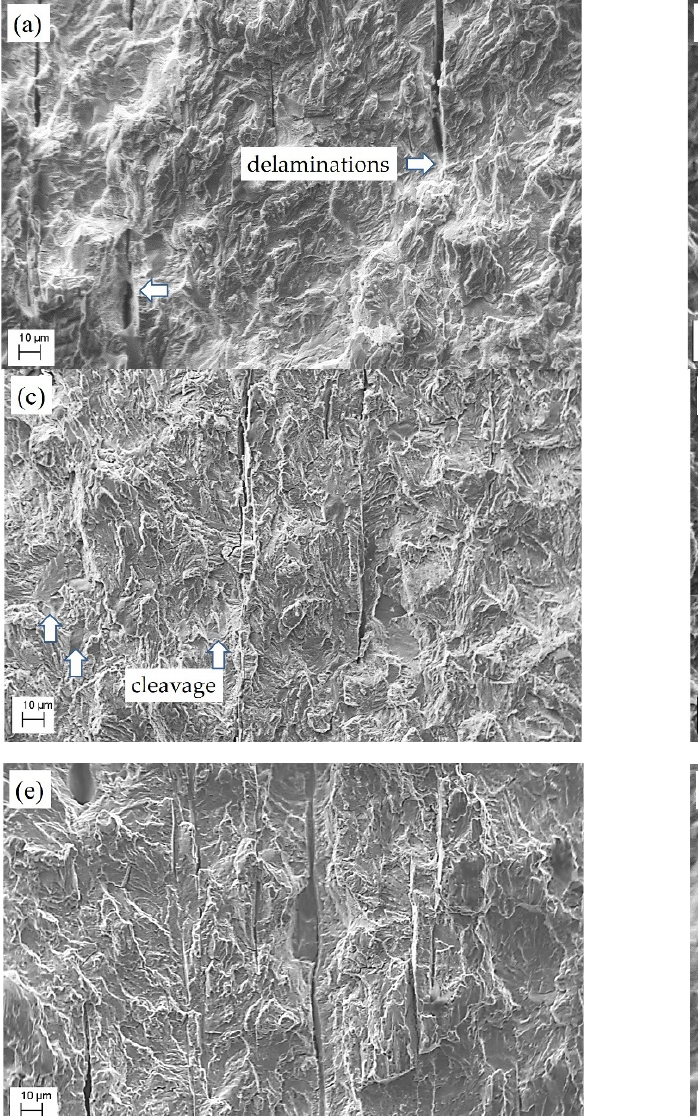
Figure 12. SEM fractography of specimens of 17H1S steel ( a , b ) in the AR state and ( c – f ) after LTO cut from the upper ( c , d ) and lower ( e , f ) parts of the corresponding pipe in the positions close to its inner surface and undergoing the FCG resistance test at a frequency of 10 Hz and a stress ratio of